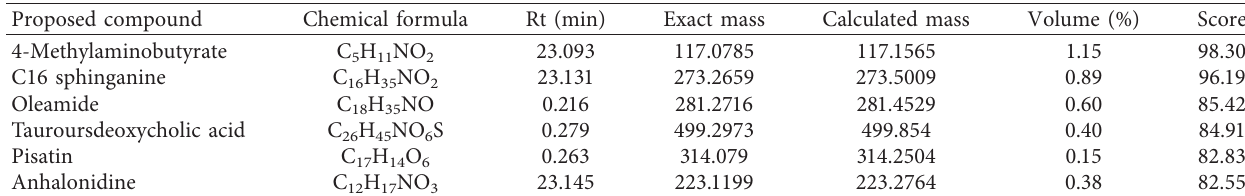
Tauroursdeoxycholic